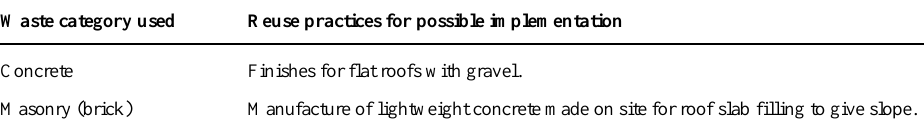
Table 3. CDW reuse practices at the construction site.